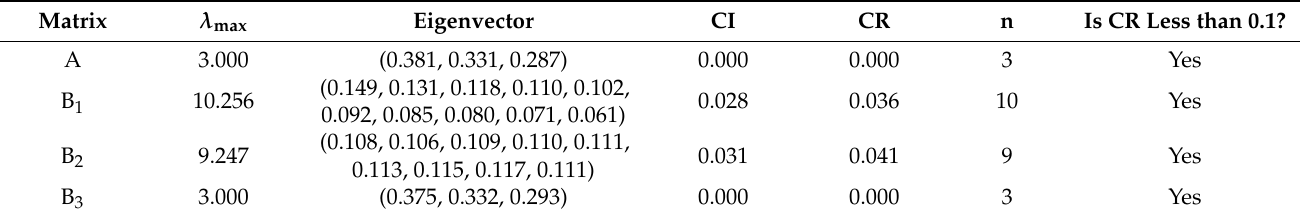
Table 7. Hierarchical single sorting and consistency